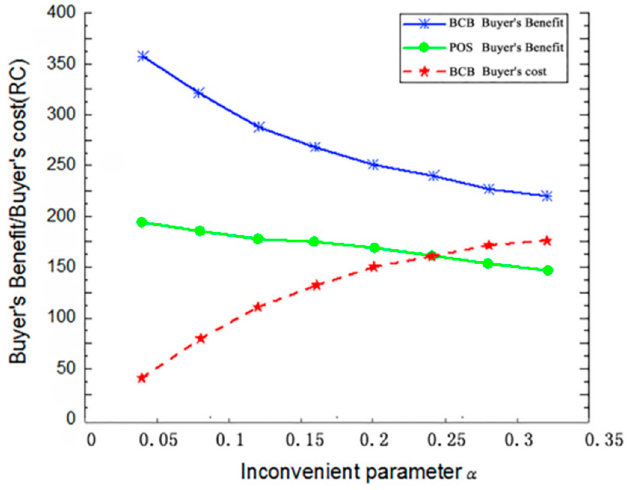
Figure 6. Influence of inconvenient parameter α on buyer’s benefit and